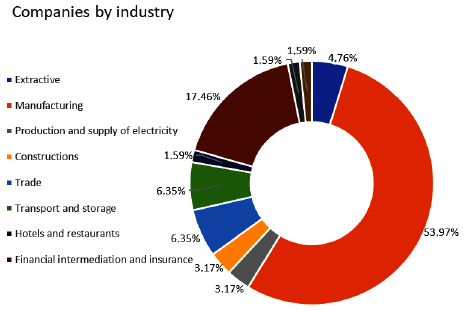
Figure 2. The structure of the companies analysed by the industry in which they operate (source: own projection based on BSE database